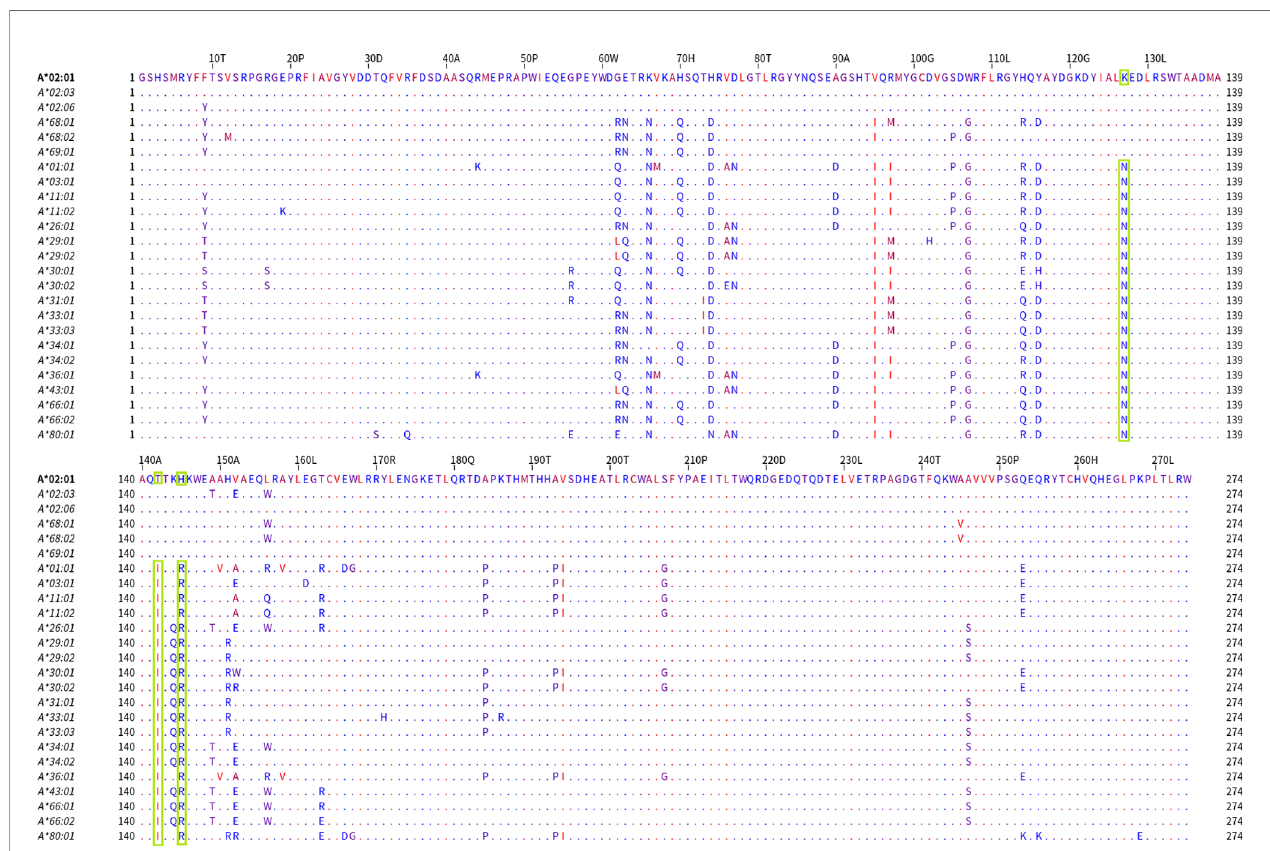
FIGURE 3 | Mature protein sequence alignments for PCA de fi ned groups of HLA-A antigens. Residues are colored according to the hydrophobicity scale of Kyte, J., and Doolittle, R.F. This scale can be used for identifying surface-exposed regions. The most hydrophobic residues are colored red, and the most hydrophilic ones are colored blue. Changes in the patterns of amino acid conservation between group 1 (A*02:01, A*02:03, A*02:06, A*68:01, A*69:02) and group 2 (A*01:01, A*03:01, A*11:02, A*26:01, A*29:01, A*29:02, A*30:01, A*30:02, A*31:01, A*33:01, A*33:03, A*34:01, A*34:02, A*36:01, A*43:01, A*66:01, A*66:02, A*74:01, A*80:01) are highlighted in green rectangles. Described eplet 144TKH is the overall distinctive factor between the groups that PCA